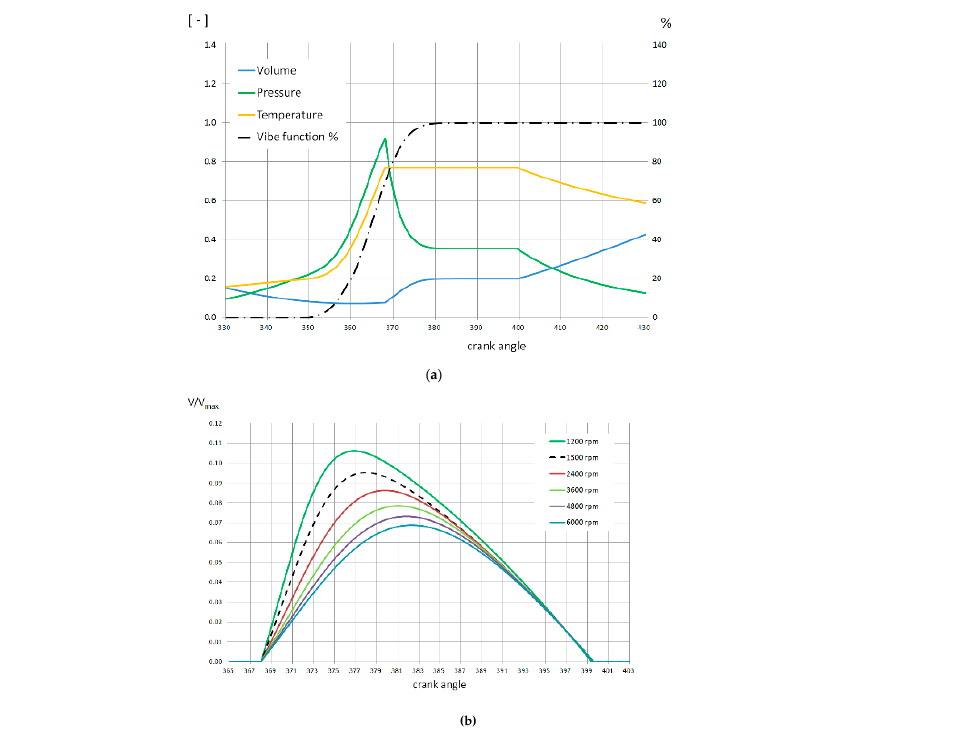
Figure 4. ( a ) A fragment of the parameters V, p, T, and the Vibe function for the proposed theoretical cycle in the form of an open diagram for the compression ratio cr 14:1. ( b ) required reaction of the complementing system cr 14:1 as a function of rotational speed (rpm). Energies 2021 , 14 , x FOR PEER REVIEW